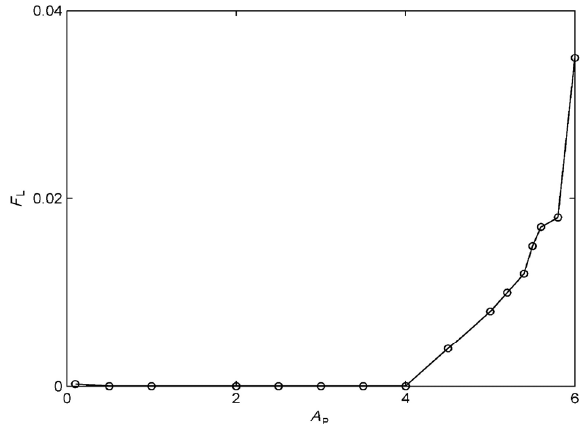
Fig. 1 Dependence of average friction force on substrate pinning intensity.